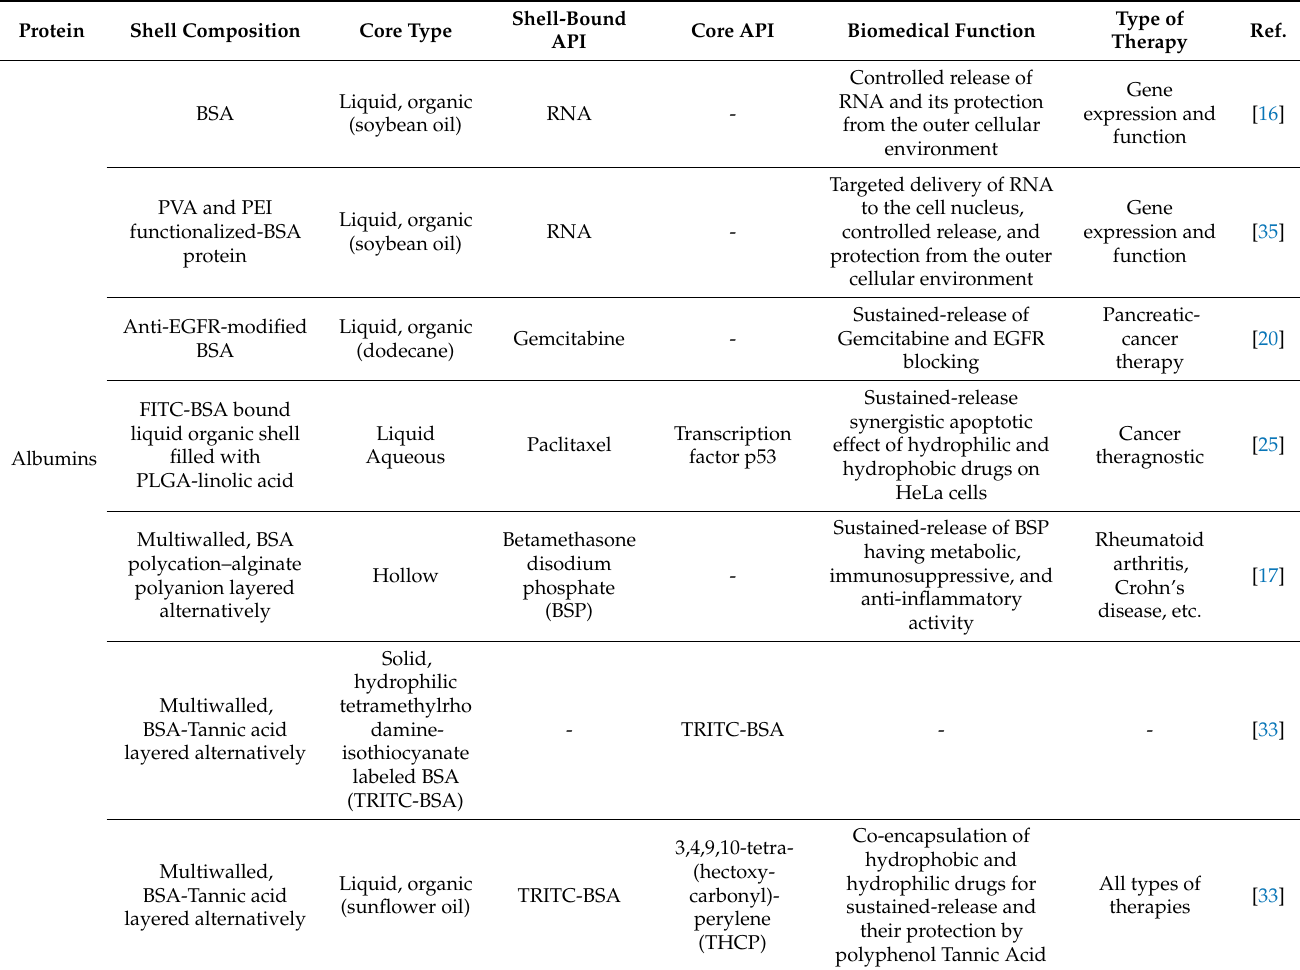
Table 5. Recent advances in the biomedical applications of protein-based solid/liquid/hollow capsules.